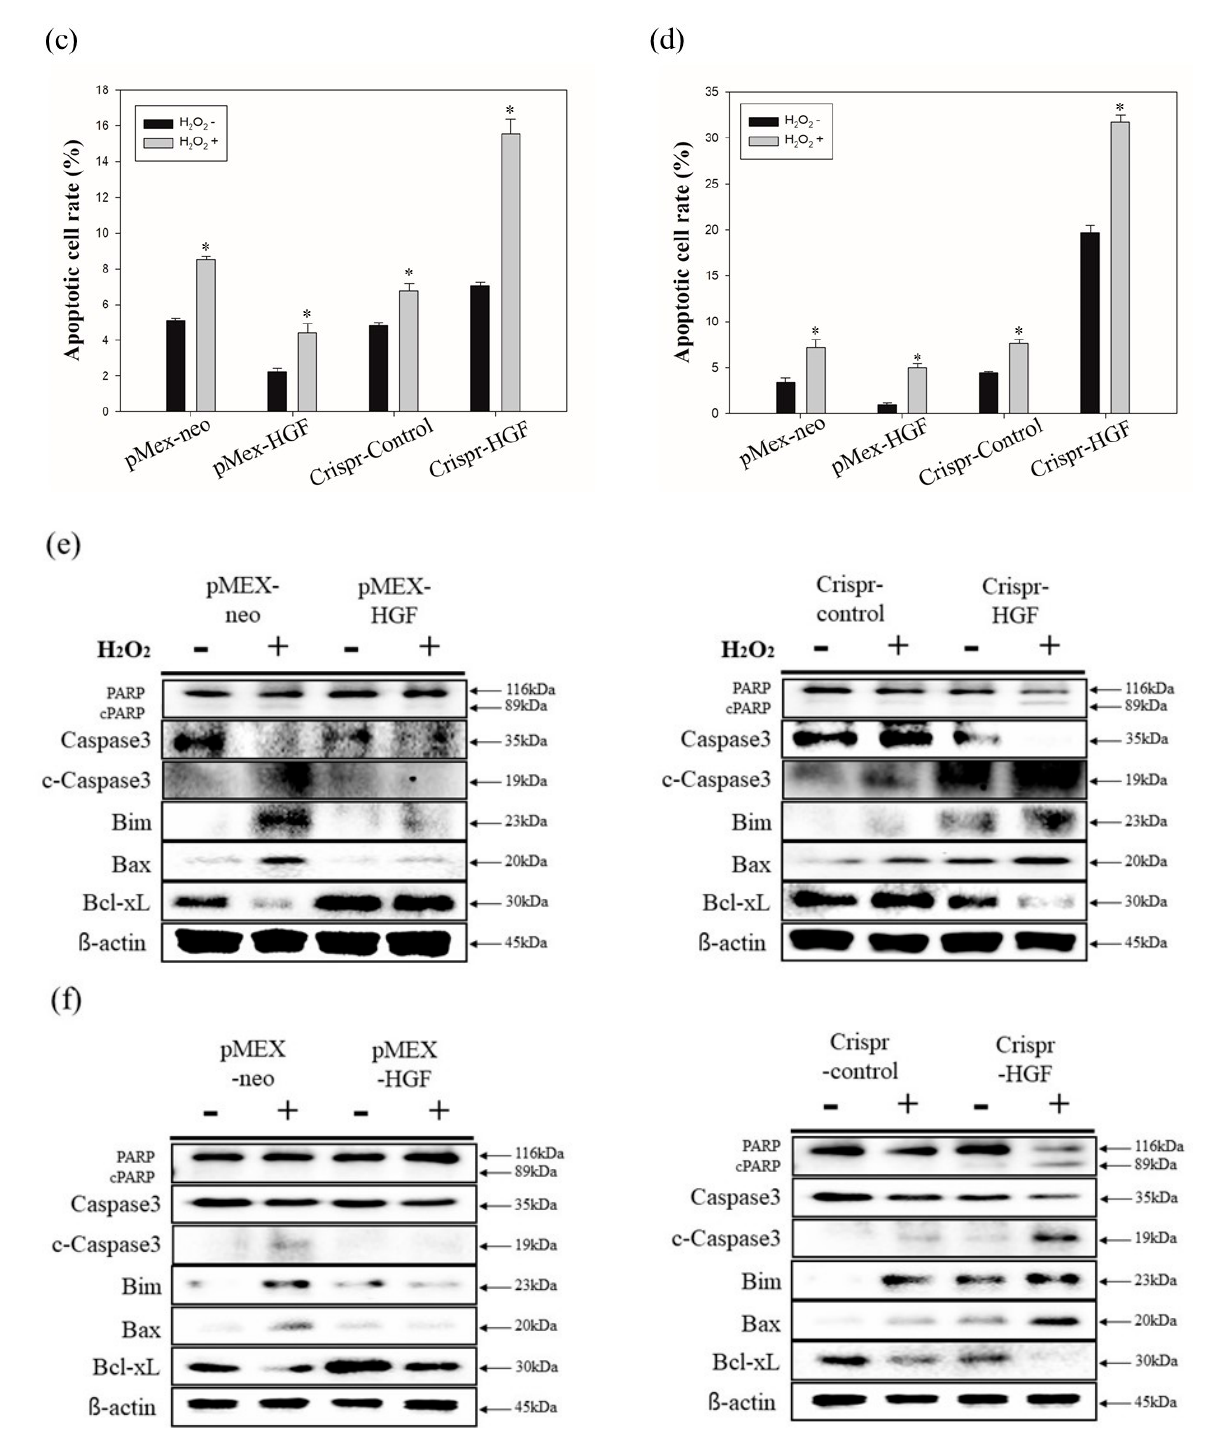
Figure 10. Synergistic apoptotic effects of H 2 O 2 and Crispr ‐ HGF. Annexin V/PI staining assay determine if the induction of apoptosis by transfection of Crispr ‐ HGF and treatment of H 2 O 2 in ( a ) Huh7 and ( b ) Hep3B cells. Apoptotic cells rate was increased by 9.8% in Crispr ‐ HGF group and H 2 O 2 treated group compared to Crispr ‐ Control group in Huh7 cells ( c ). In addition, apoptotic cells rate was increased by 26.43% in Crispr ‐ HGF group and H 2 O 2 treated group compared to Crispr ‐ Control group in Hep3B cells ( d ). Error bar represents the mean ± SEM. * p < 0.05. These assays were performed at least three times in triplicate. Western blot assay was performed to detect proteins relate to apoptosis in ( e ) Huh7 and ( f ) Hep3B cells. The expression levels of PARP, and caspase3 and those of cleaved forms were detected. Furthermore, the expression levels of Bim, Bax, and Bcl ‐ xL were detected. β‐ actin was used as a loading control.